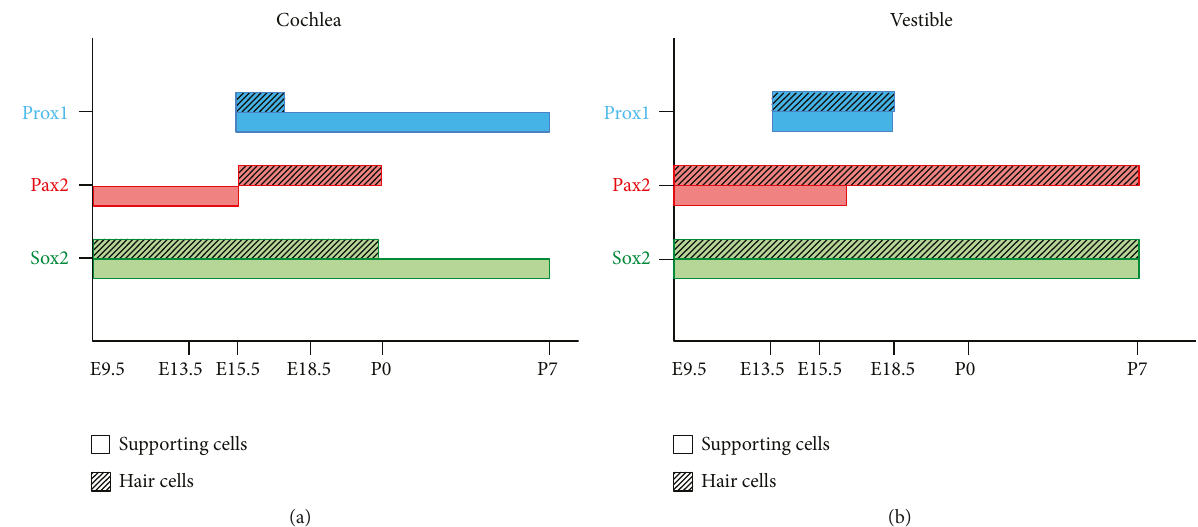
Figure 8: Schematic diagram of Sox2, Pax2, and Prox1 gene expression during mouse inner ear